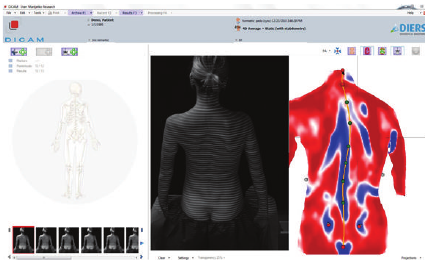
Figure 1: Static mode mean curvature screen: the middle image is raster line projection; the far right image is a representation of spinal curvature based surface